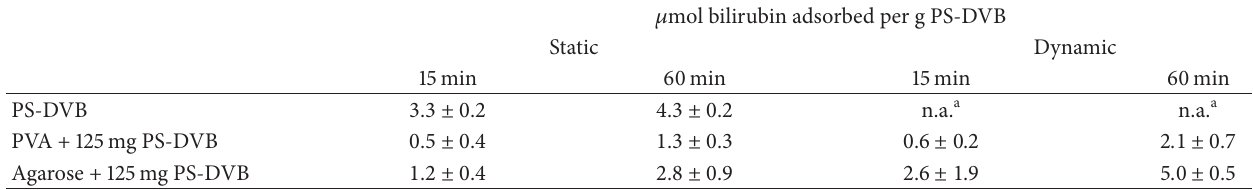
Figure 2: Scanning electron micrographs of plain agarose cryogels (a)-(b) and agarose-based composite cryogels loaded with 125 mg PS-DVB microparticles (c)-(d). Table 2: Adsorption of bilirubin under static and dynamic conditions after 15 and 60 min ( 𝑛 = 3 ).